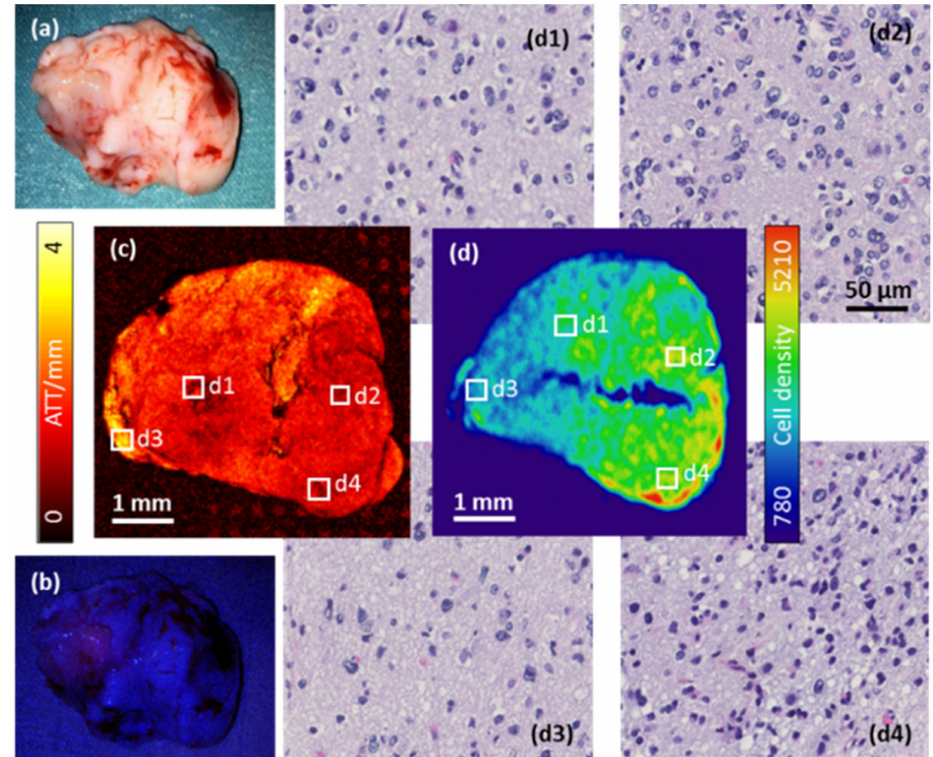
Figure 3. Large field-of-view (FOV) scan of a representative astrocytoma, WHO grade III case with a vaguely fluorescent 5-ALA hotspot. ( a ) Photograph and ( b ) fluorescence image of a sample of the compact tumor immediately after resection. ( c ) Attenuation en-face projection and ( d ) whole sample cell density map with ( d1 – d4 ) corresponding regions of interest upon H&E